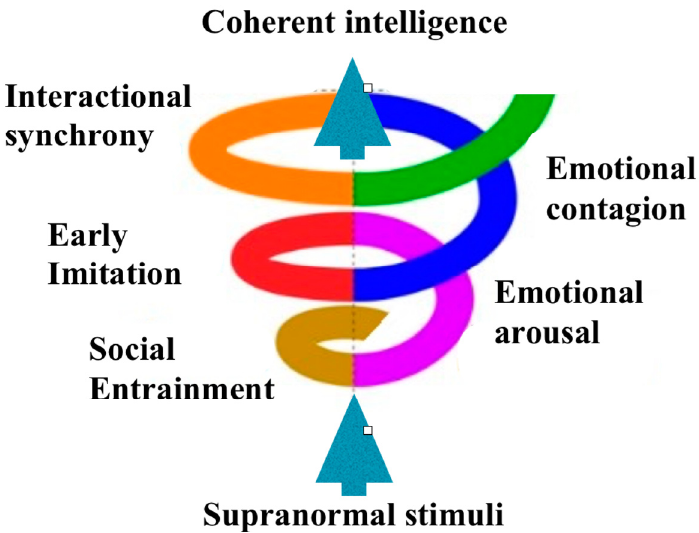
Figure 1. The Model of Coherent Intelligence in interpersonal dynamics of individuals from psychophysi- ological coherence to coherent intelligence (Reprinted with permission from Danilov and Mihailova